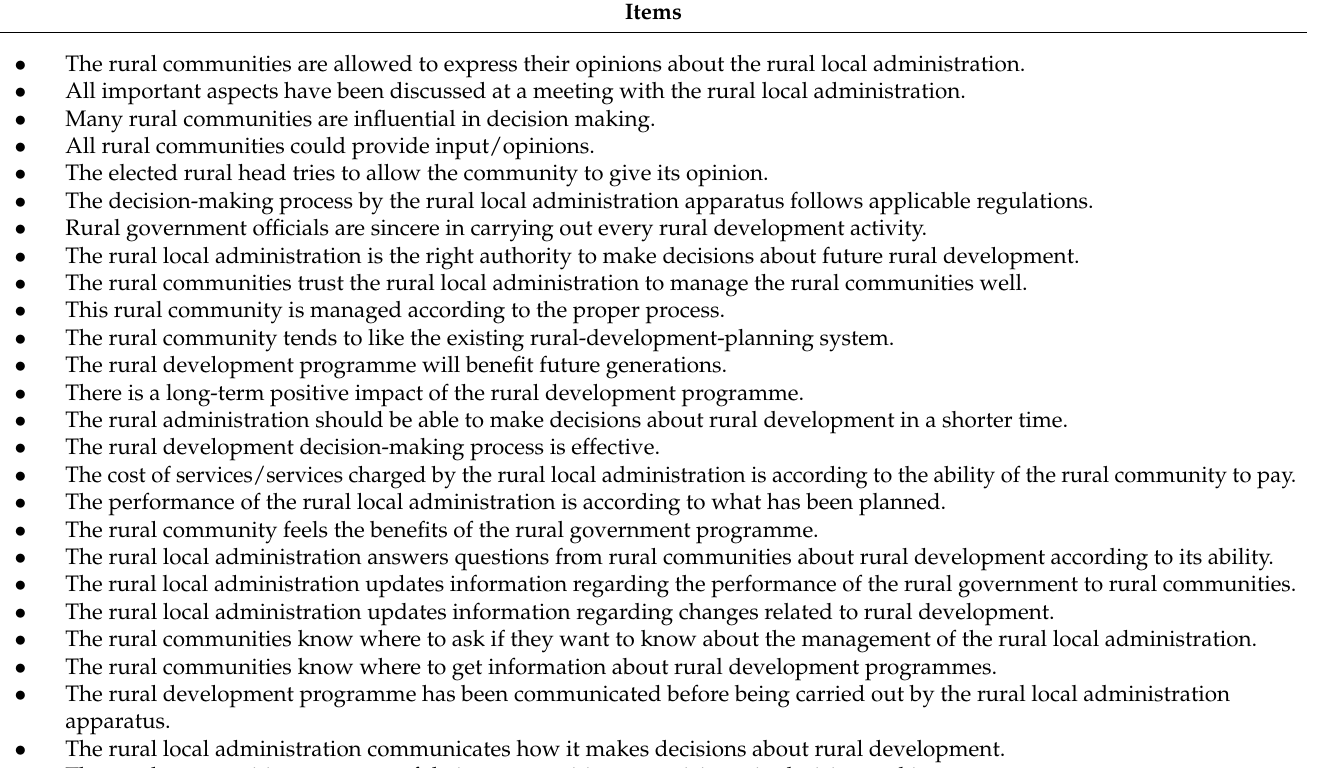
Table A1. Research Questionnaire. (Respondents completed the questionnaire, with responses ranging from strongly disagree (1) to strongly agree